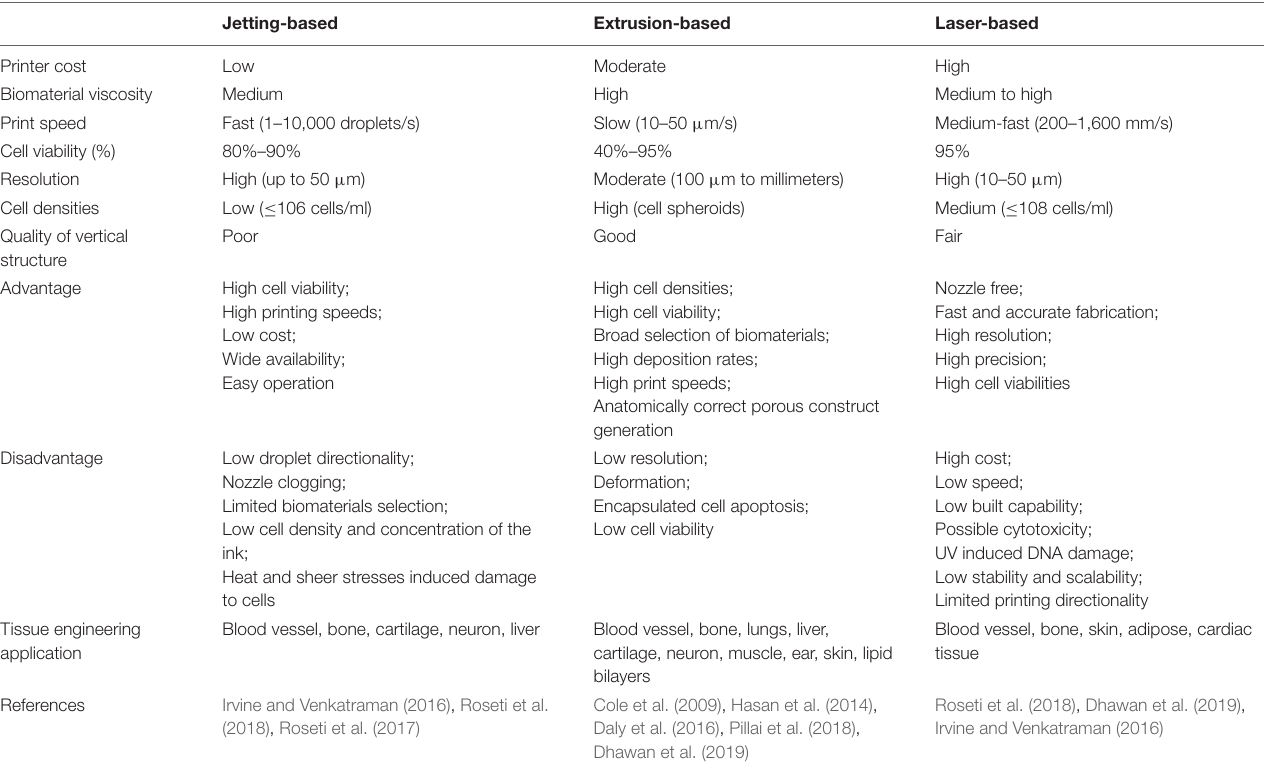
TABLE 3 | Comparison of the three types of 3-D bioprinting